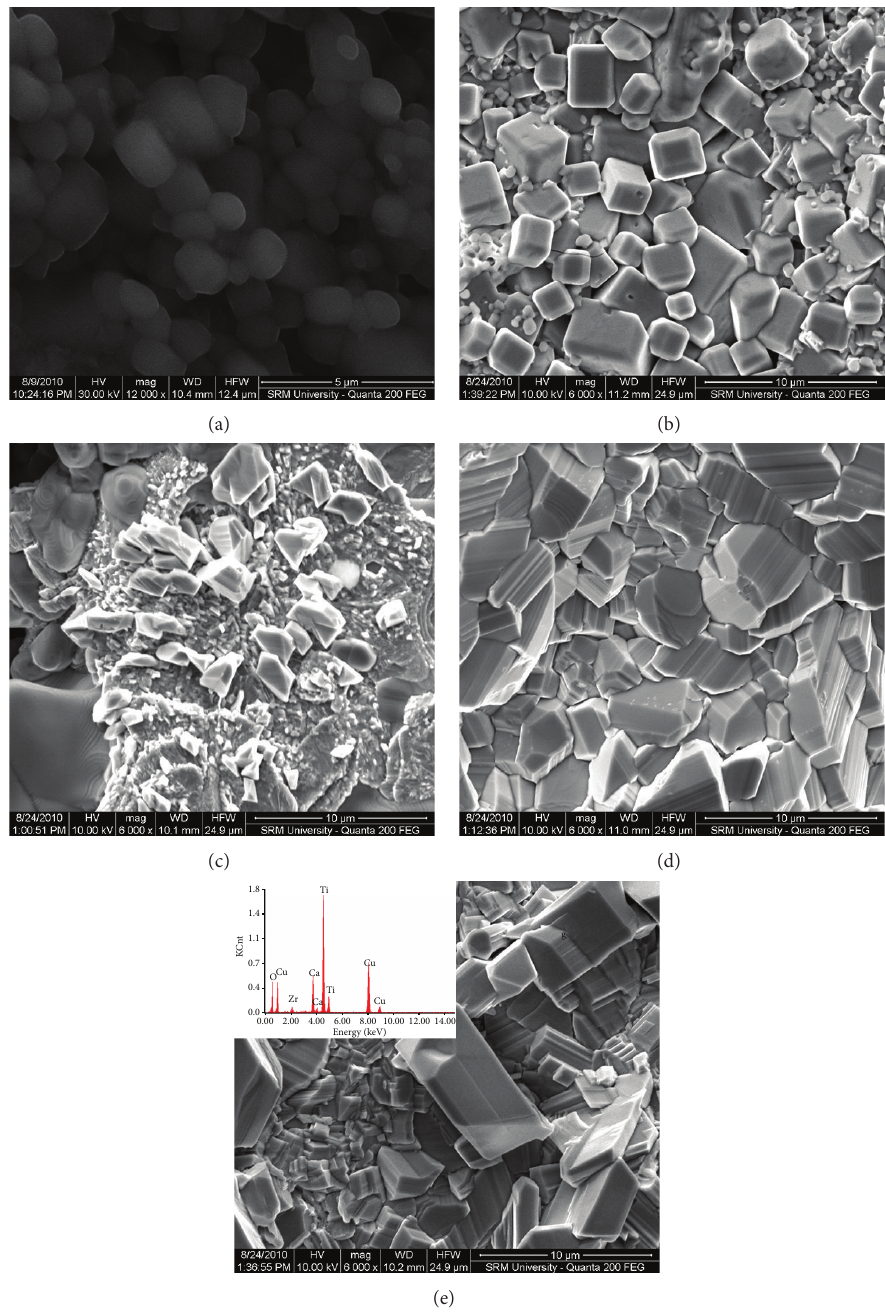
Figure 2: FE-SEM micrographs of CaCu 3 Ti 4−𝑥 Zr 𝑥 O 12 (microwave sintered at 1000 ∘ C–10min) (a) when 𝑥 = 0 , (b) 𝑥 = 0.02 , (c) 𝑥 = 0.10 , (d) 𝑥 = 0.20 , and (e) 𝑥 = 0.50